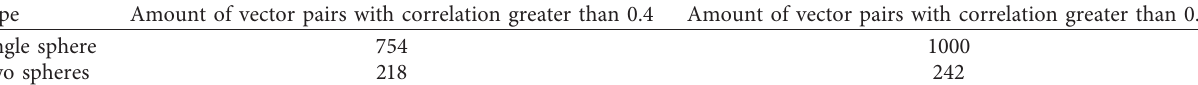
Table 1: The correlation of the measurement matrices derived from the single and double spherical sampling methods.